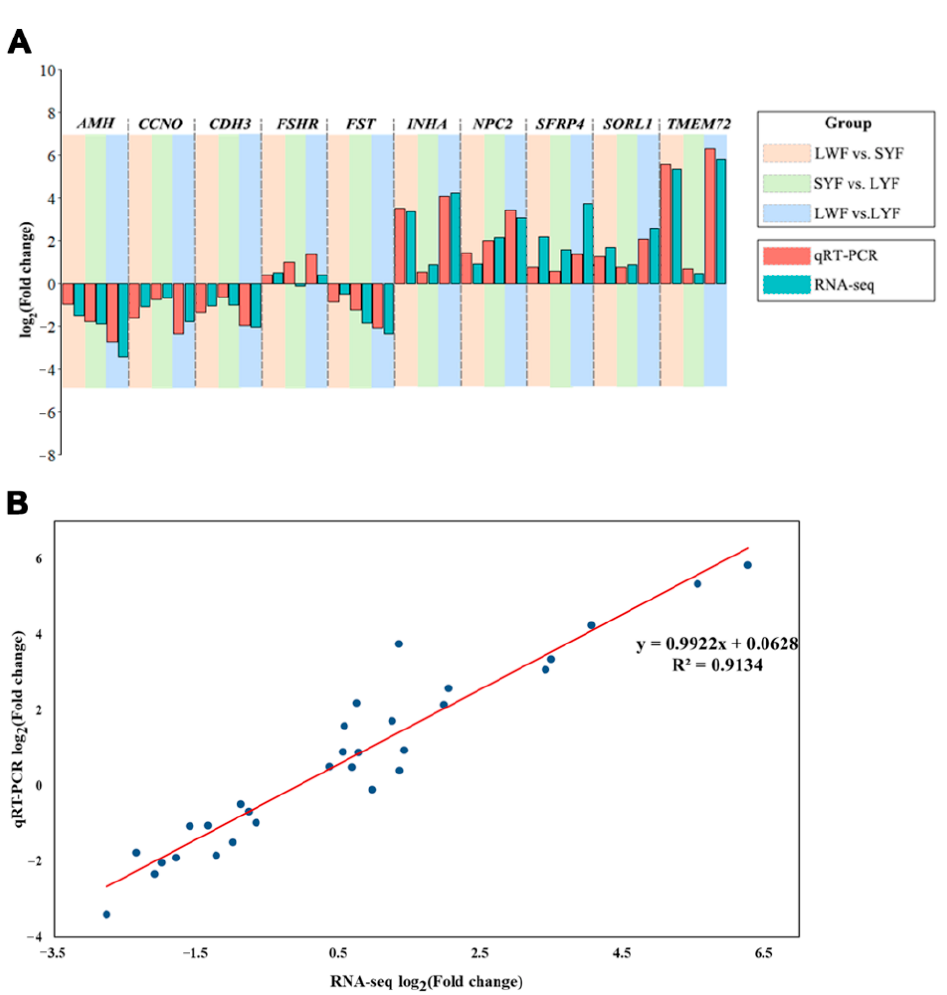
Figure 5. Validating the RNA-seq data by qRT-PCR. ( A ) Comparison of log (cid:2870) fold change in 10 dif- ferentially expressed genes (DEGs) between qRT-PCR and RNA-seq and ( B ) regression analysis of | log 2 fold change | values between qRT-PCR and RNA-seq. A high R (cid:2870) indicated that the RNA-seq data were considered to be of a high accuracy.